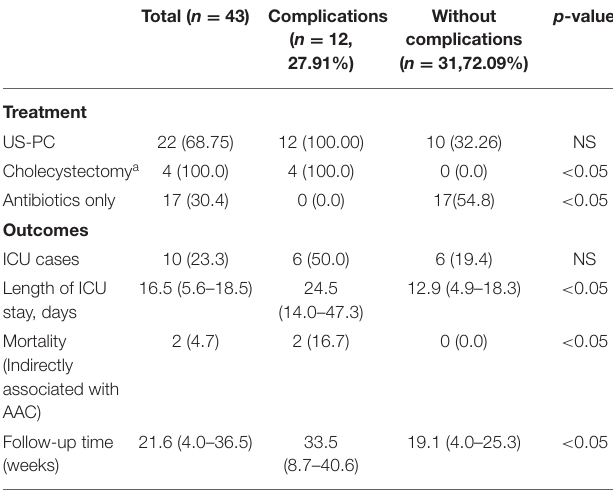
TABLE 5 | Treatment and outcomes of AAC patients with complications vs. without